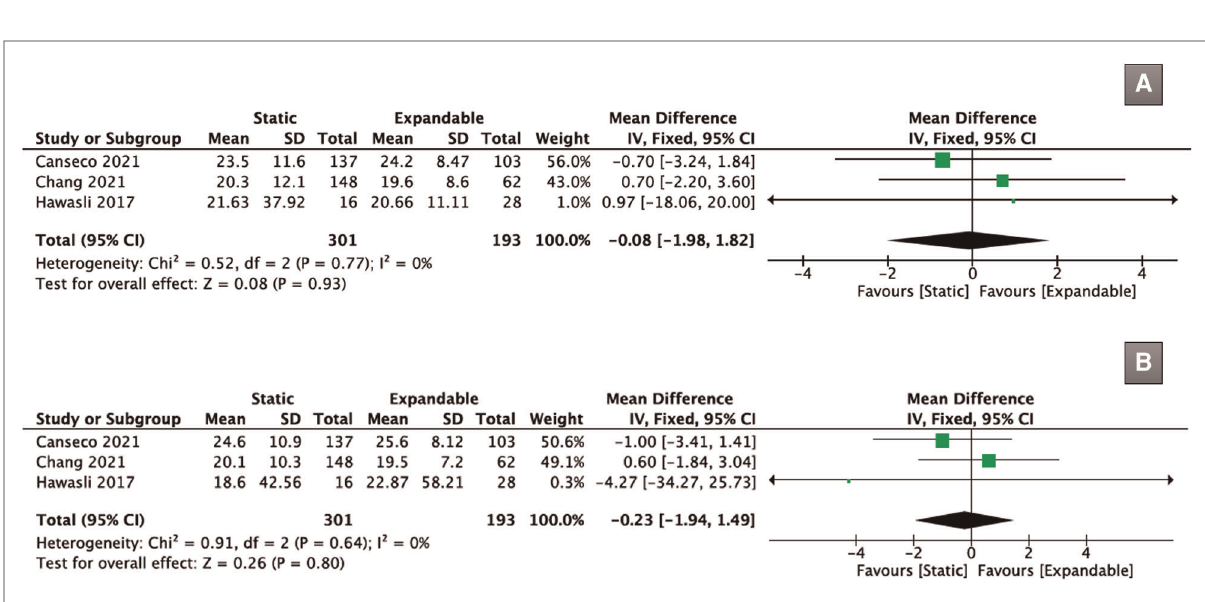
FIGURE 6 Forest plots for comparison of PT at preoperative ( A ) and fi nal follow-up ( B ) between the static and expandable groups. PT: pelvic